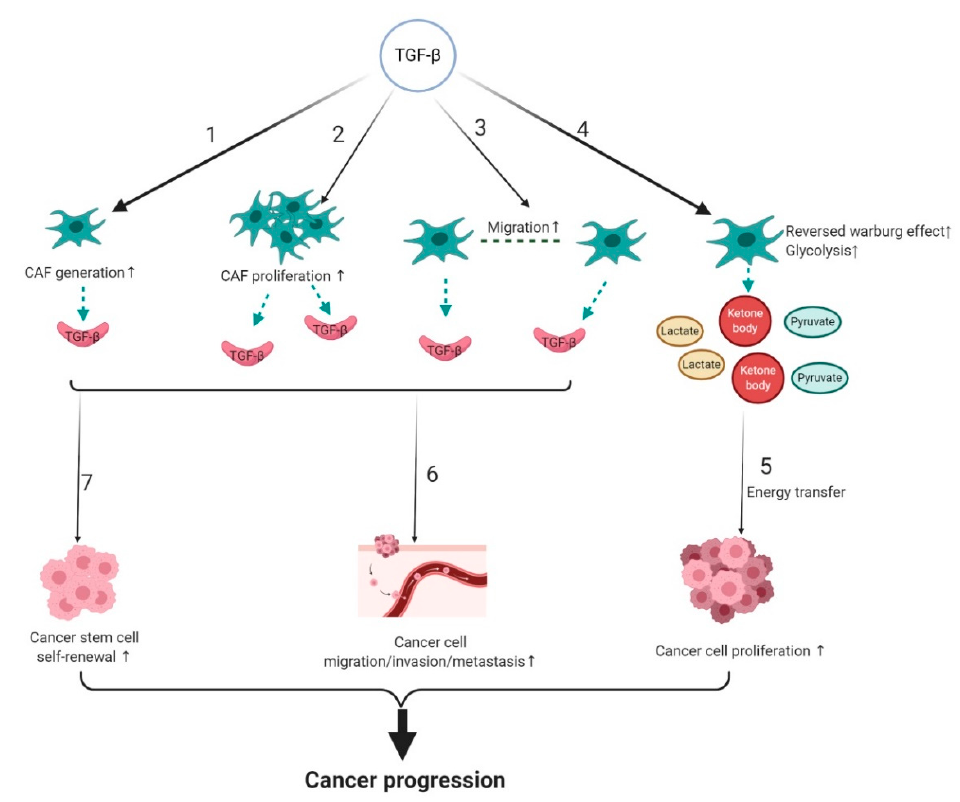
Figure 3. TGF- β signaling contributes to CAF-mediated cancer progression. TGF- β activation promotes 1. CAF formation; 2. CAF proliferation; 3. CAF migration; and 4. CAF glycolysis; 5. CAF energy production to fuel cancer cells. TGF- β secreted by CAFs or TGF- β activated CAFs increases 6. cancer cell migration / invasion / metastasis; and 7. cancer stem cell self-renewal ability. These processes all contribute to cancer progression. The black arrows indicate activation / promotion of the indicated cell type / process. The green dotted arrows indicate cytokine paracrine / energy production. CAF, cancer-associated fibroblast.